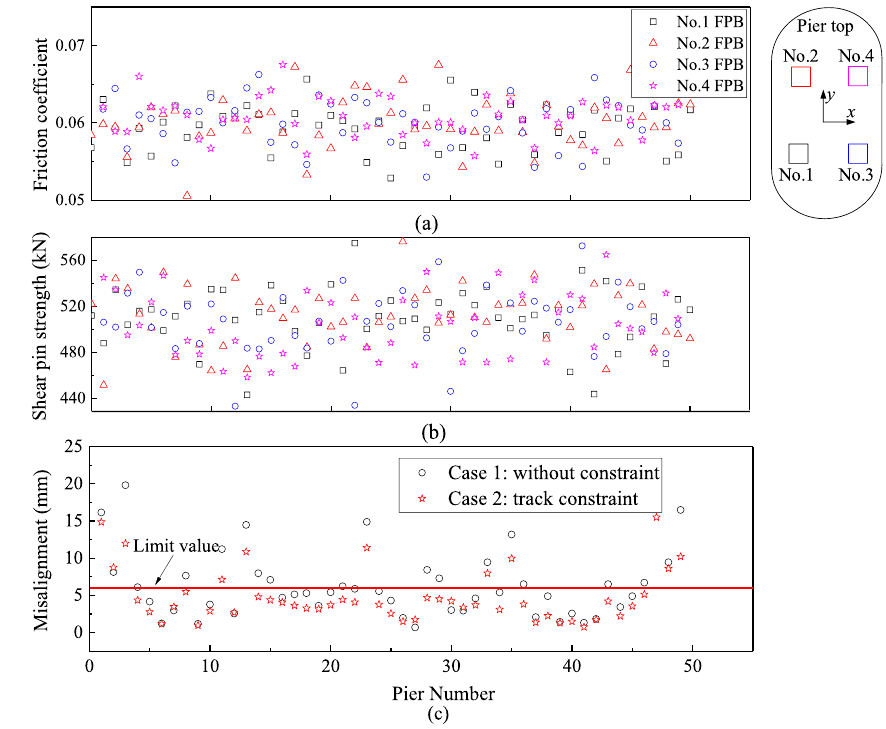
Fig. 13 FPB properties and maximum misalignment: a friction coefficient; b strength; and c misalignment